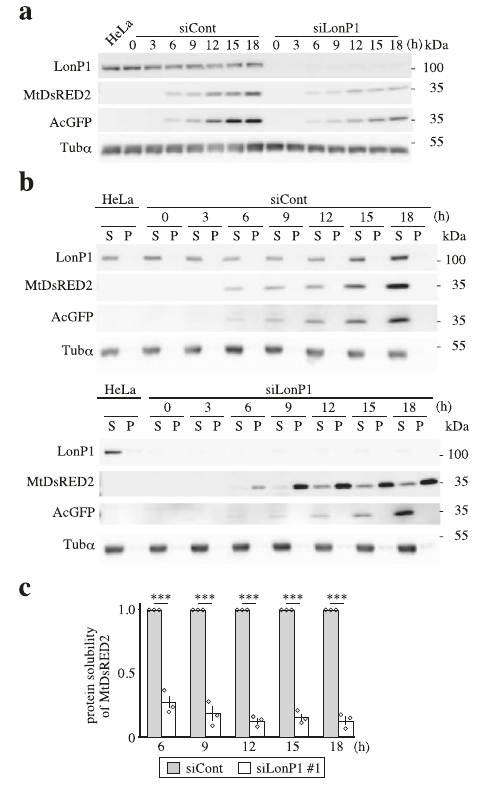
Fig. 5 LONP1 helps solubilize newly imported proteins. Immunoblot analysis of transiently expressed mitochondria-targeted Mt-DsRed2 and